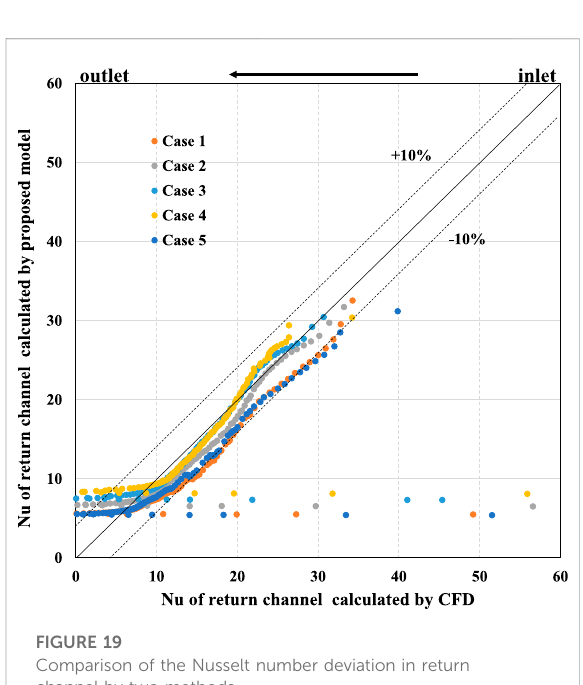
FIGURE 19 Comparison of the Nusselt number deviation in return channel by two methods.